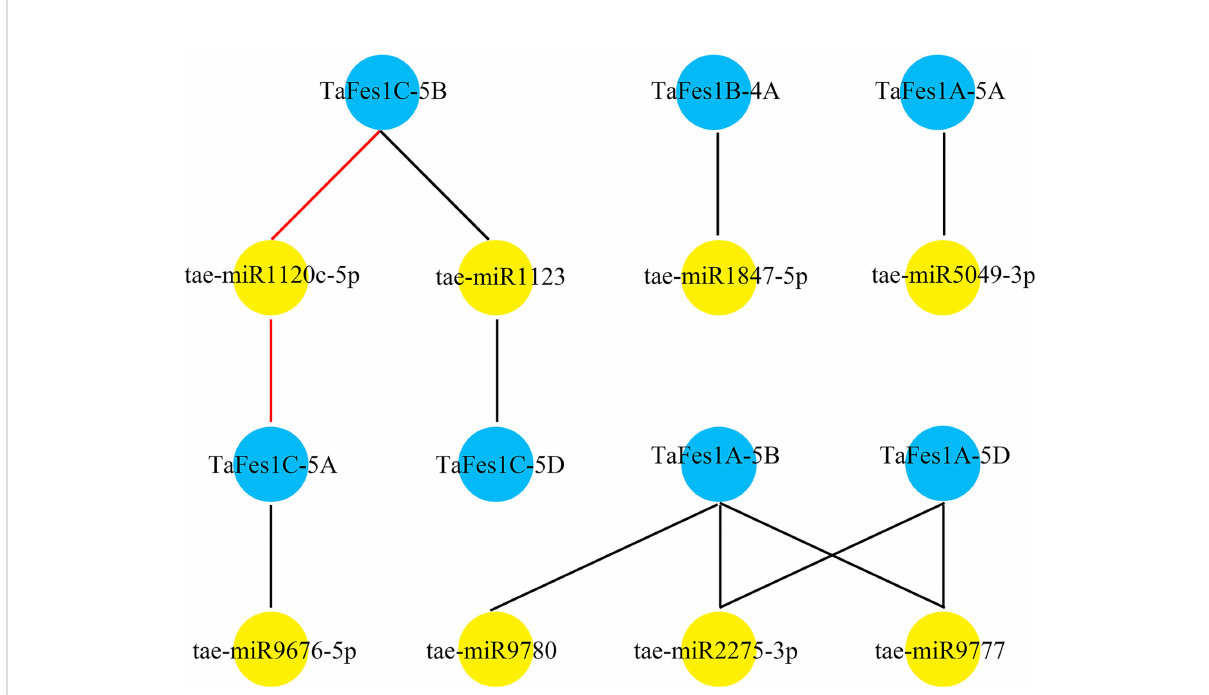
FIGURE 4 Potential regulation association between miRNAs and TaFes1s . MiRNAs are represented by yellow circles and TaFes1s are represent by blue circles. Dark lines link miRNAs and TaFes1s indicate the regulation relationship are transcription cleavage, and red lines are translation